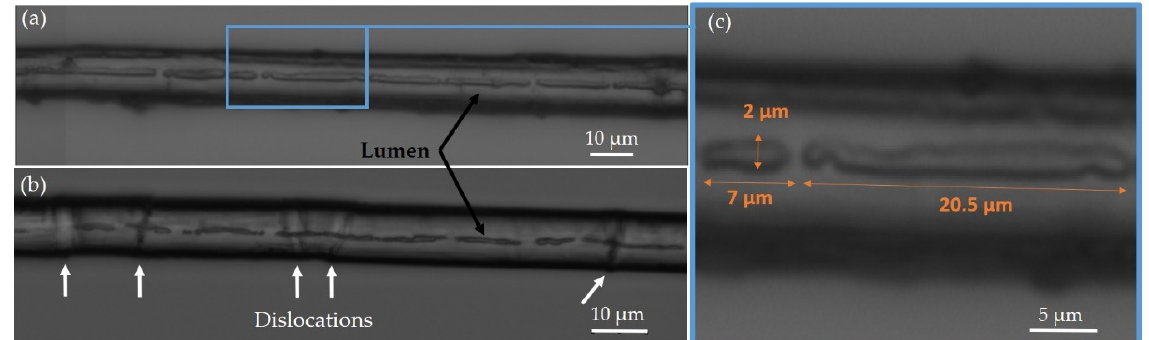
Figure 7. ( a , b ): Optical observations along two flax fibres focusing on their central lumen segments, which appear as darker areas, and dislocations evidenced by white arrows; ( c ): enlarged area of the flax fibre represented on ( a ), with measurements of the lumen segments width and lengths .